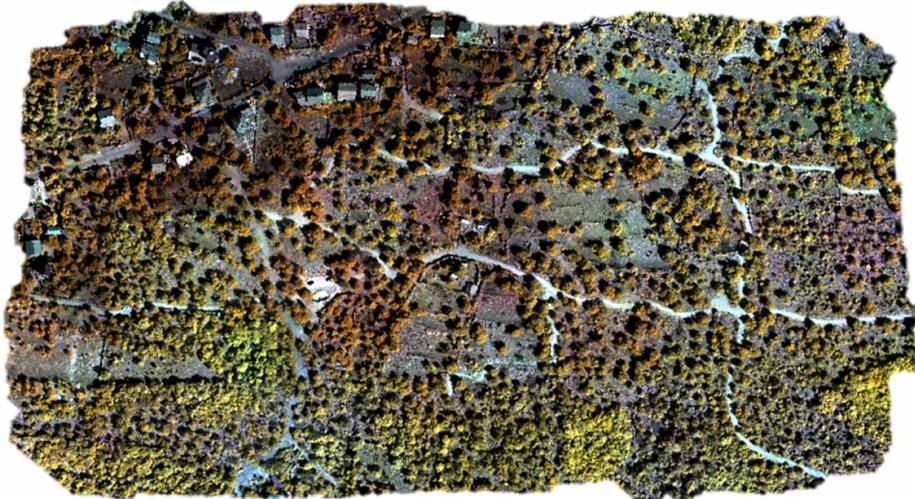
Figure 10. MS model with 10-9-8 bands